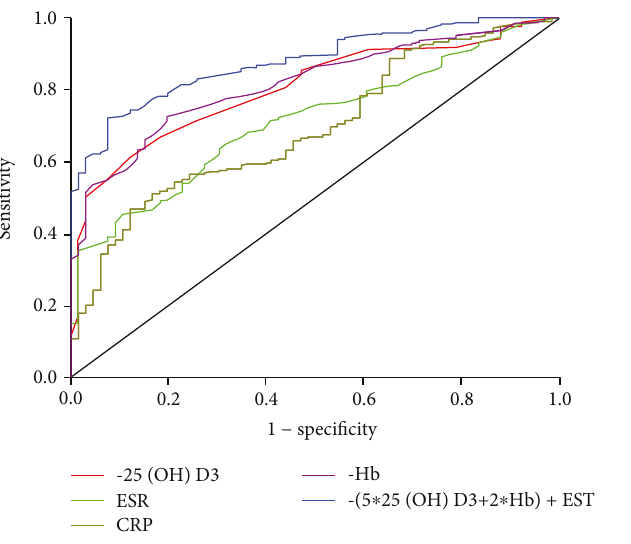
Figure 1: Receiver-operating characteristic curves of various parameters for active disease. The areas under the receiver- operating characteristic curve were 0.804 and 0.816 for − 25(OH)D3 and − Hb, respectively, higher than those of CRP (0.693) and ESR (0.713) for distinguishing active from inactive Crohn ’ s disease with P < 0 005 . The areas under the receiver-operating characteristic curve for − Hb vs. − 5 ∗ 25 OH D3 + 2 ∗ Hb + ESR were higher than those of − 25(OH)D3 and − Hb with P < 0 005